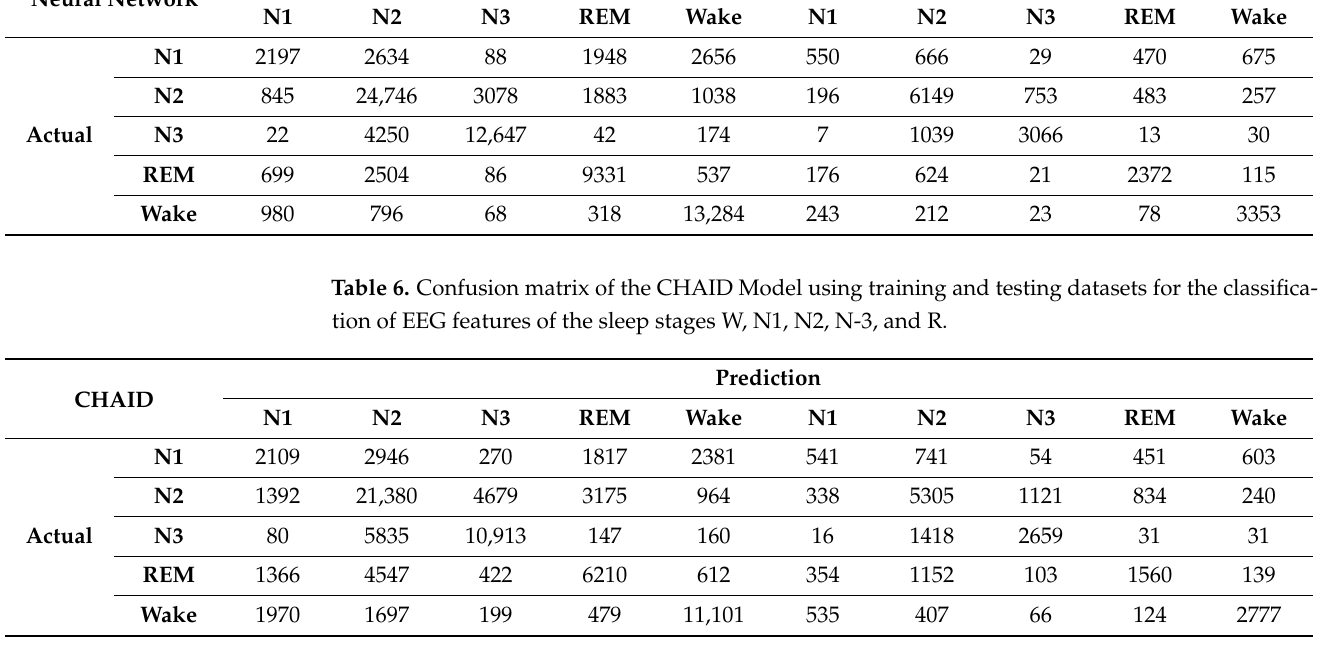
The C5.0 model showed 94% accuracy using the training dataset and 87% accuracy using the testing dataset for multi-class classification of sleep stages (Table 7). N3 and W stages were most accurately classified with accuracy for training (95% and 96%) and testing (91% and 92%). The wake stage was classified with the highest sensitivity for training (92%) and testing (81%). The sensitivity of the C5.0 model was the lowest in the N1